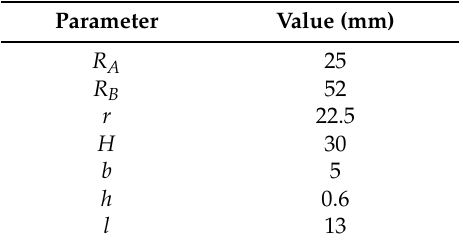
Table 1. Parameters of the six-axis accelerometer.